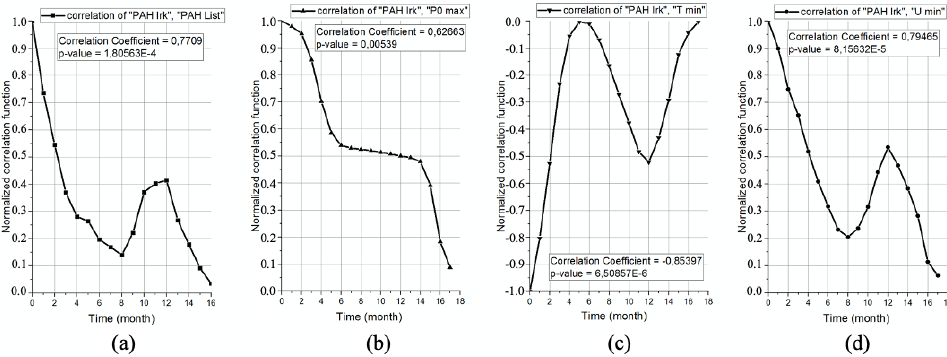
Figure5. Normalisedcross-correlation functions between( a ) the average monthly total PAHs in Ir- kutsk and Listvyanka,( b ) the total PAHs and Р0 max , ( c ) the total PAHs and Tmin,( d ) the total PAHs and Umin.